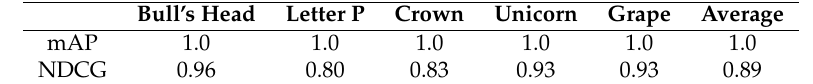
Table 5. mAP and NDCG scores of the best performing system on TestSet50 broken down by category.